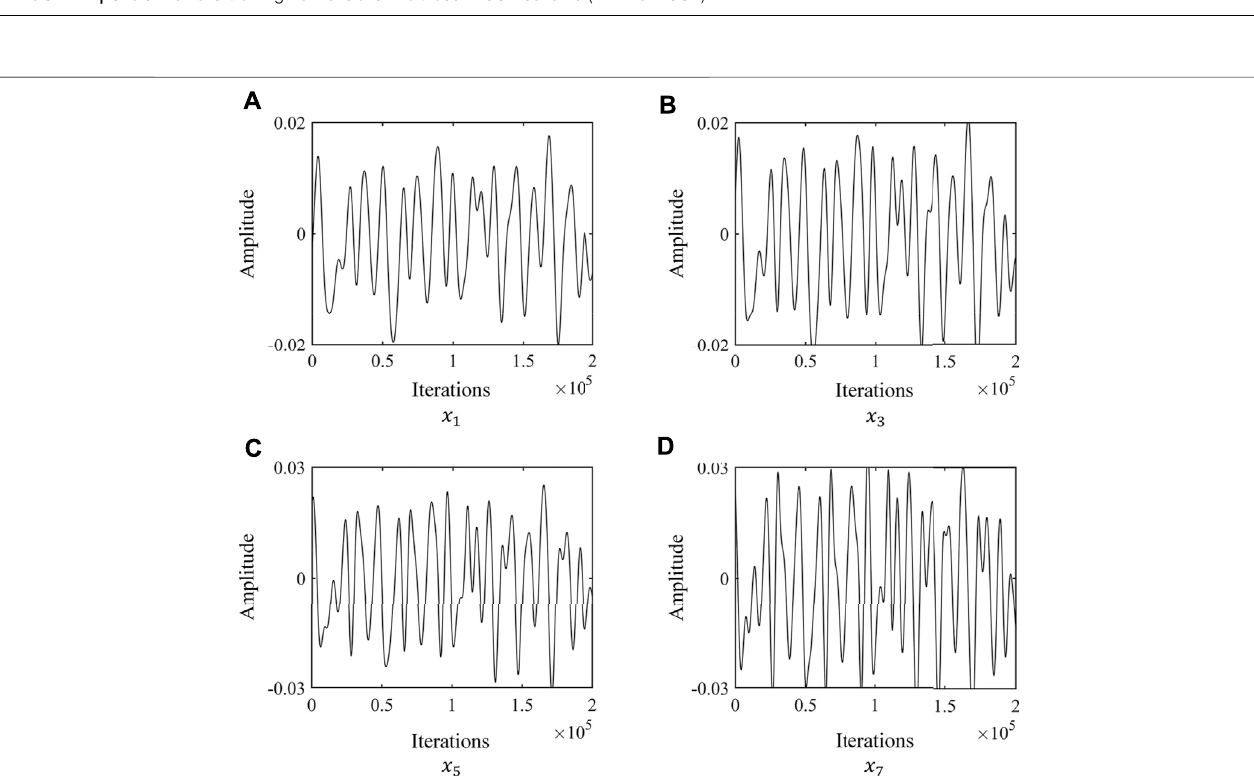
FIGURE 2 | Waveform of output sequence: (A) , the waveform of x 1 . (B) , the waveform of x 3 . (C) , the waveform of x 5 . (D) , the waveform of x 7 .